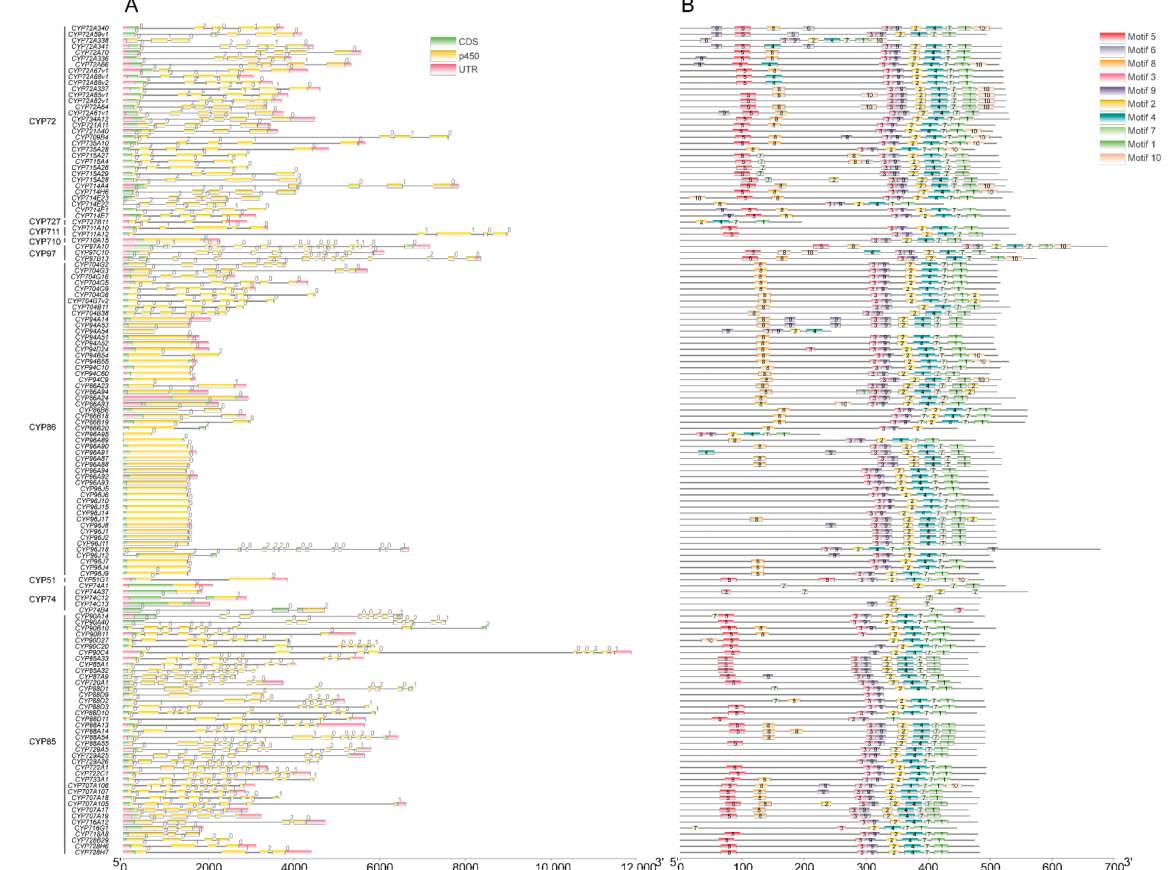
Figure 4. Gene structural features and conserved motifs of MtP450 proteins. ( A ) Gene structural features of MtP450s . “p450” indicate the conserved domain of Cytochrome p450 family, “CDS” indicated the remaining partial coding sequence. “UTR” indicates untranslated regions. The numbers 0, 1, and 2 stand for the types of intron phase. The length of the intron, exon and UTR can be estimated from the scale. ( B ) Analysis of the conserved motifs of MtP450 proteins. Each motif is represented by a colored box. Box length corresponds to motif